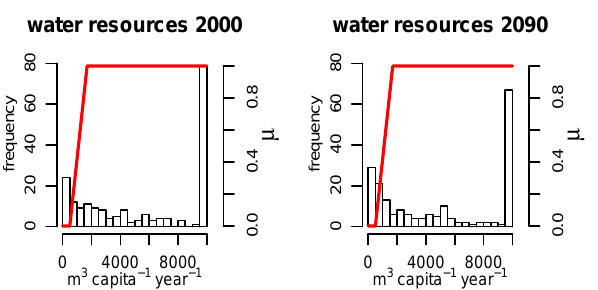
Figure A2. Frequency distributions of the input data and membership functions for water resource availability. Values show the ensemble mean across all ISI-MIP climate and impact models for the two 30-year